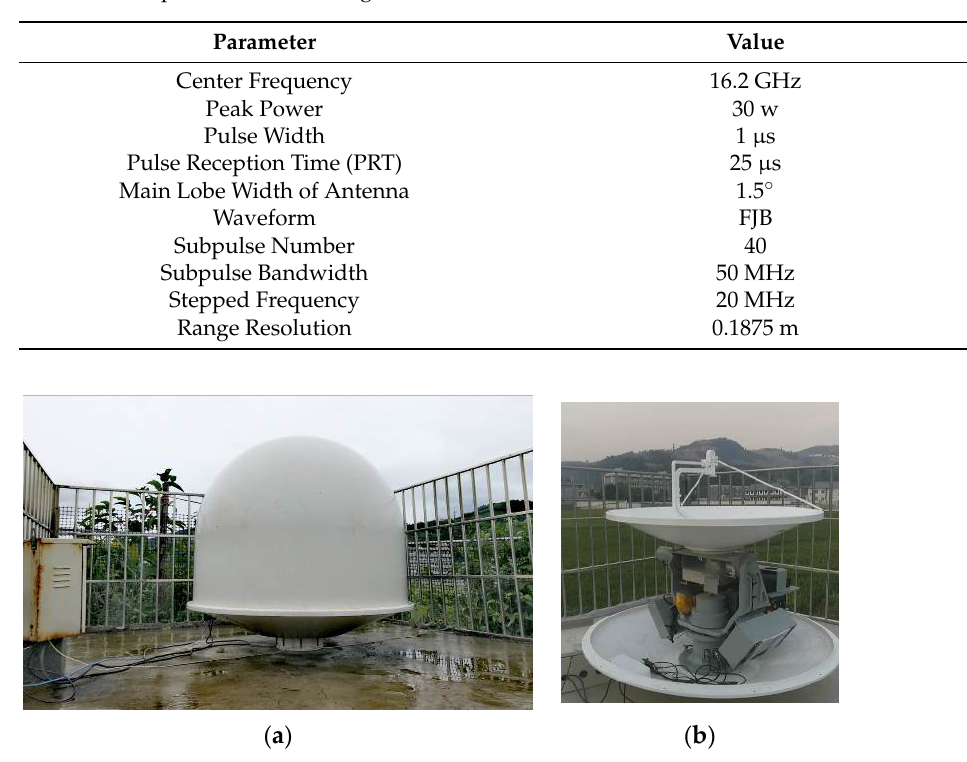
Table 2. Main parameters of the high-resolution coherent VLR.